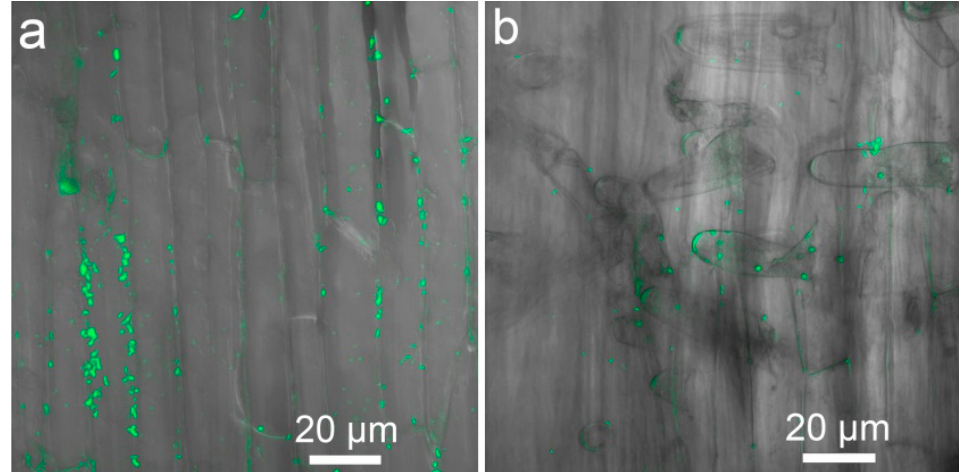
Figure 6. Confocal laser scanning images showing localization examples of Pseudomonas fluorescens SPB2137gfp attached to the root surface ( a ) and root hairs ( b ) of pea genotype VIR1903 treated with 80 µM AlCl 3 . The bacteria are colored in green. Images are 10 merged optical sections.